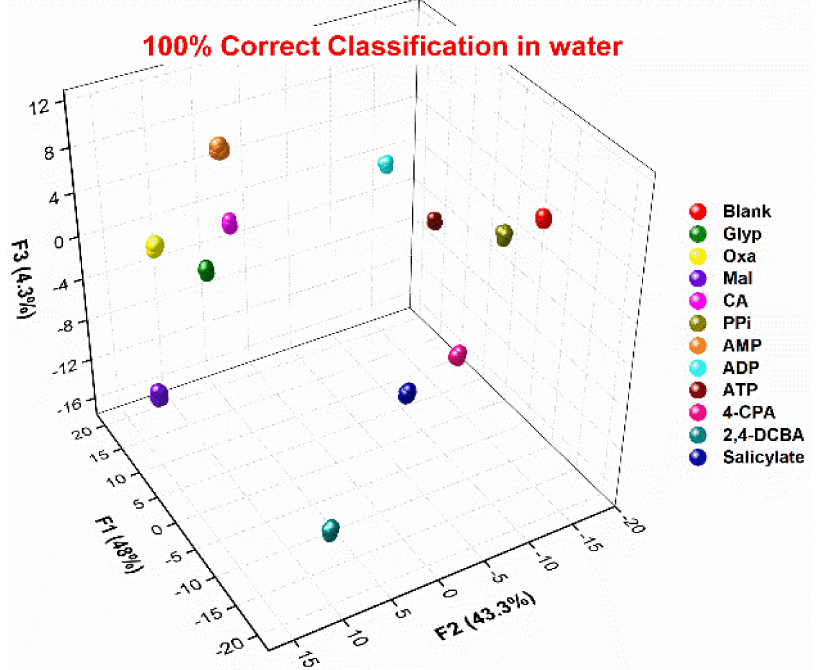
Figure 8. LDA plots for the data matrix of the response of the chemosensor array to 11 analytes and blank in MES buffer (10 mM). (analyte) = 5 mM; 20 repetitions for each analyte were measured. Cross-validation routine shows 100% correct classification.